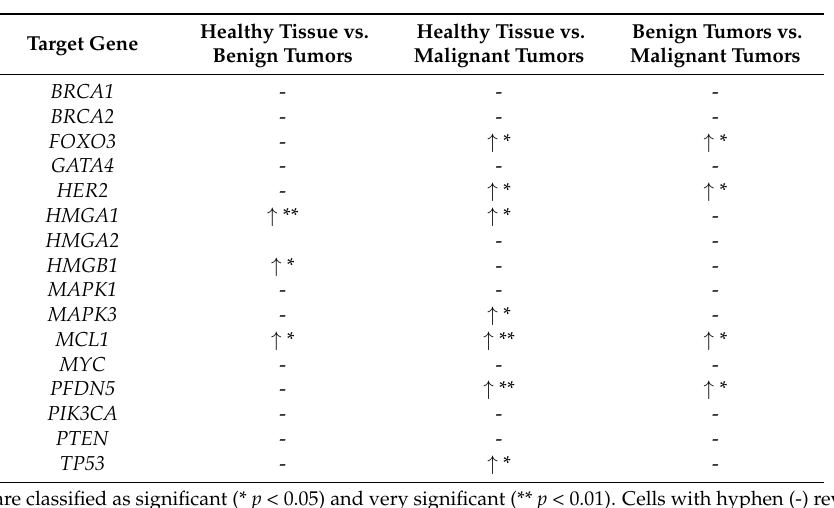
Table 2. Gene expression of the target genes when comparing the different canine mammary tissues from FF samples. Arrows show a higher or lower expression of the first group in relation to the second one (example: first group vs. second group).